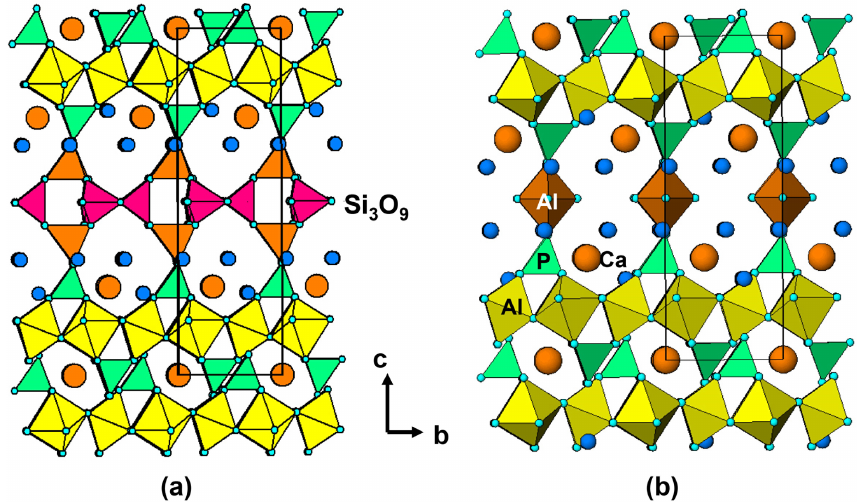
Figure 11. Two [100] projections of the crystal structures of (a) perhamite and (b) iangreyite, showing the absence of Si 3 O 9 groups and the replacement of AlO 4 tetrahedra (orange) by Al-centred trigonal prisms (brown) in